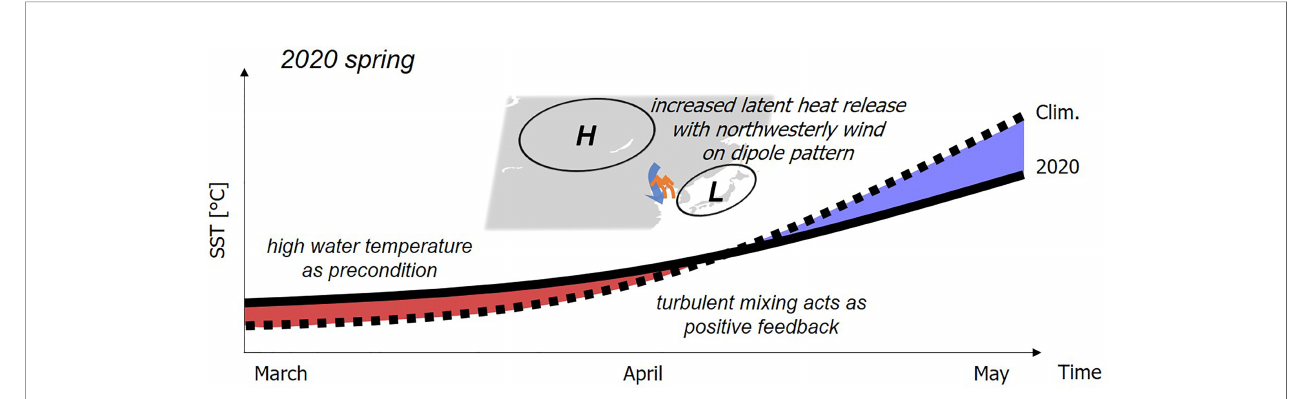
FIGURE 8 | Schematic illustrating the slow temperature evolution process during the spring of 2020. The red (blue) shaded area denotes the higher (lower) SST in 2020 than the climatology (2017 – 2019 from the S-ORS and 1982 – 2019 from the OISSTv2). The light blue and orange arrows indicate the northwesterly wind and latent heat fl ux,